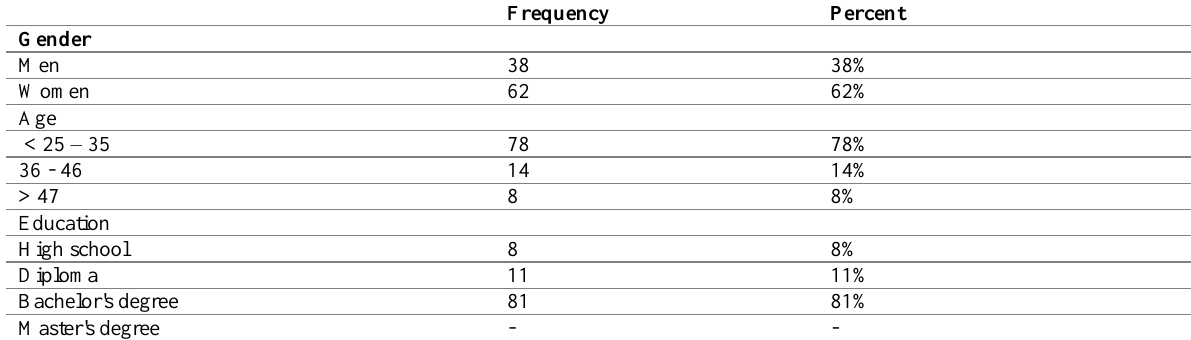
Table 1: Demographic profile of the tourist compared with the main population figures (N=100)